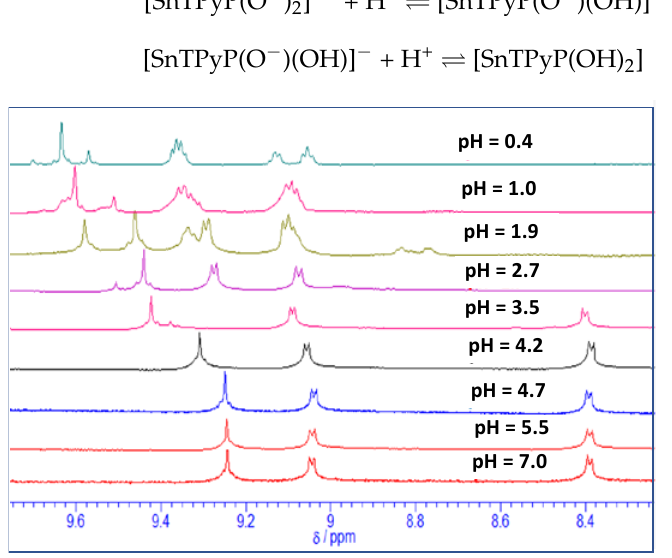
Figure 4. 1 H NMR of SnTPyP in CD 3 CN/D 2 O (8/2, v / v ) under various pH conditions. The pH was adjusted by adding deuterated sulfuric acid.